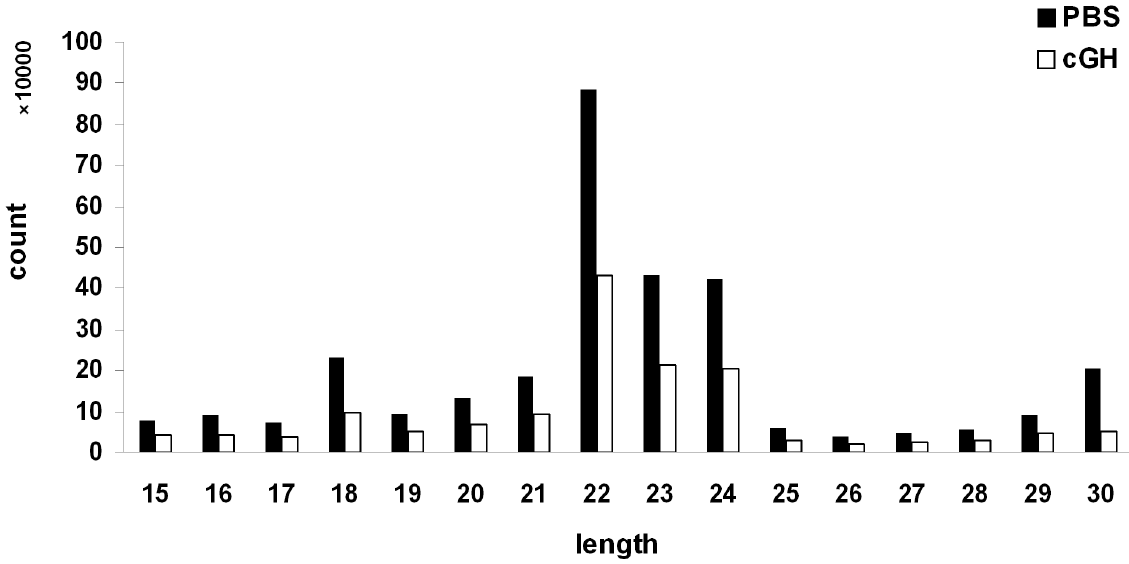
Figure 2. Length distributions of small RNA sequences.